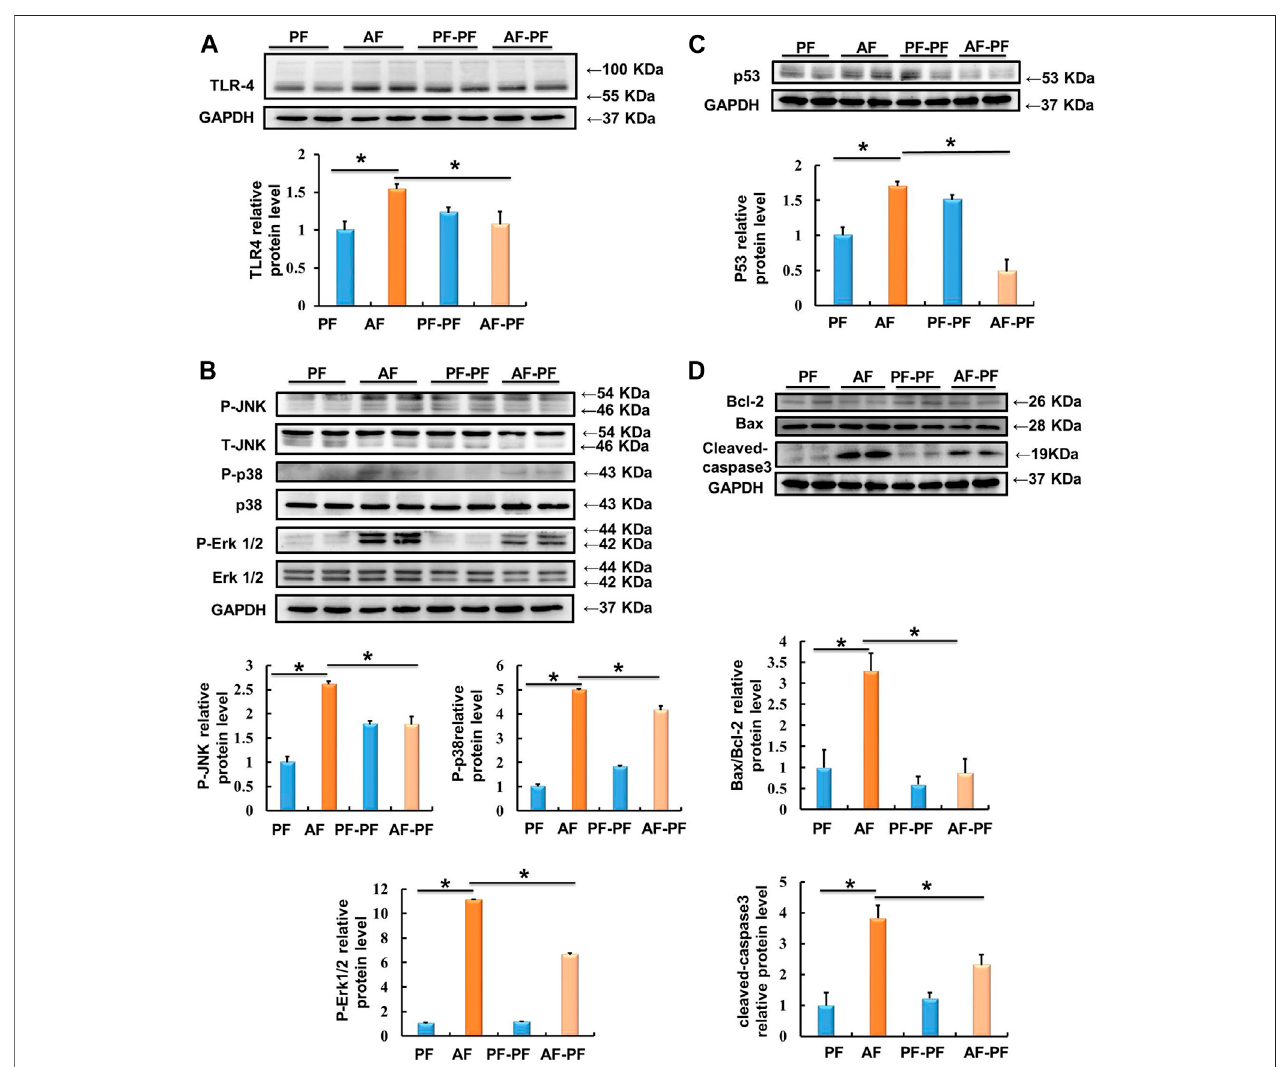
FIGURE 4 | Alcohol withdrawal rescues alcohol-stimulated TLR4/MAPKs and mitochondrial apoptotic pathways. Total cellular lysates were extracted from mice livertissues. (A,B) ImmunoblottingassaywasperformedforTLR-4,p-JNK,p-P38,andp-ERK1/2. (C,D) ImmunoblottingassaywasperformedforP53andBax/Bcl-2. * p < 0.05 indicates statistically signi fi cant differences ( n (cid:1) 8).